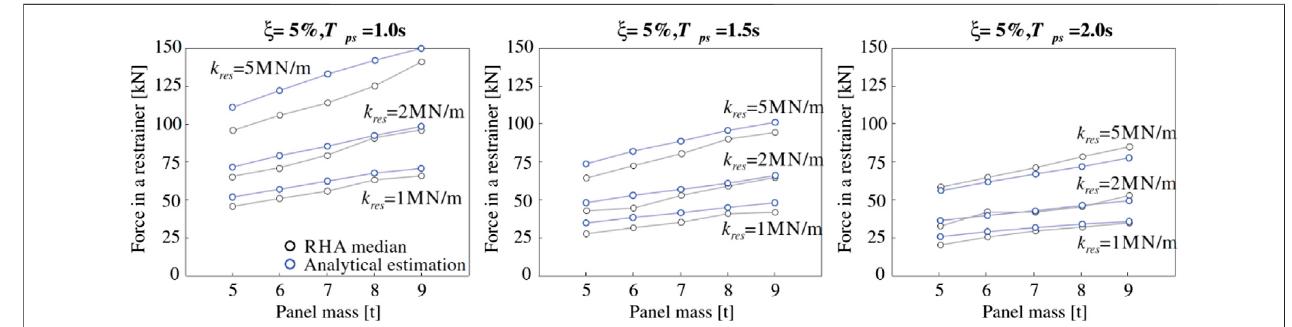
FIGURE 15 | The match between the maximal forces in a restrainer obtained by using the proposed analytical expression and the results of the response history analysis (RHA).